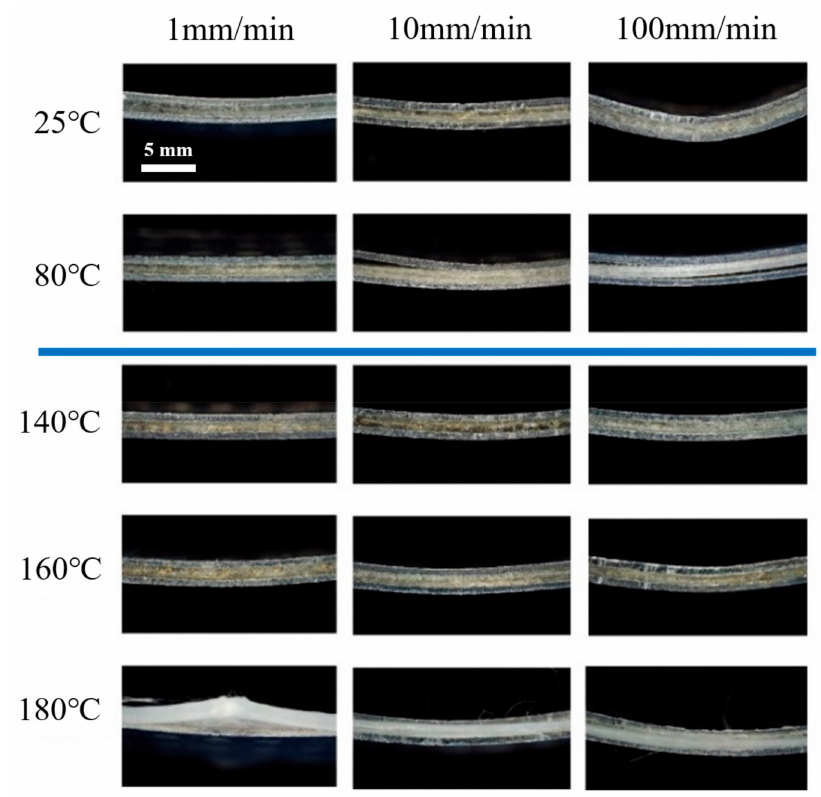
Figure 12. Failure forms under bending